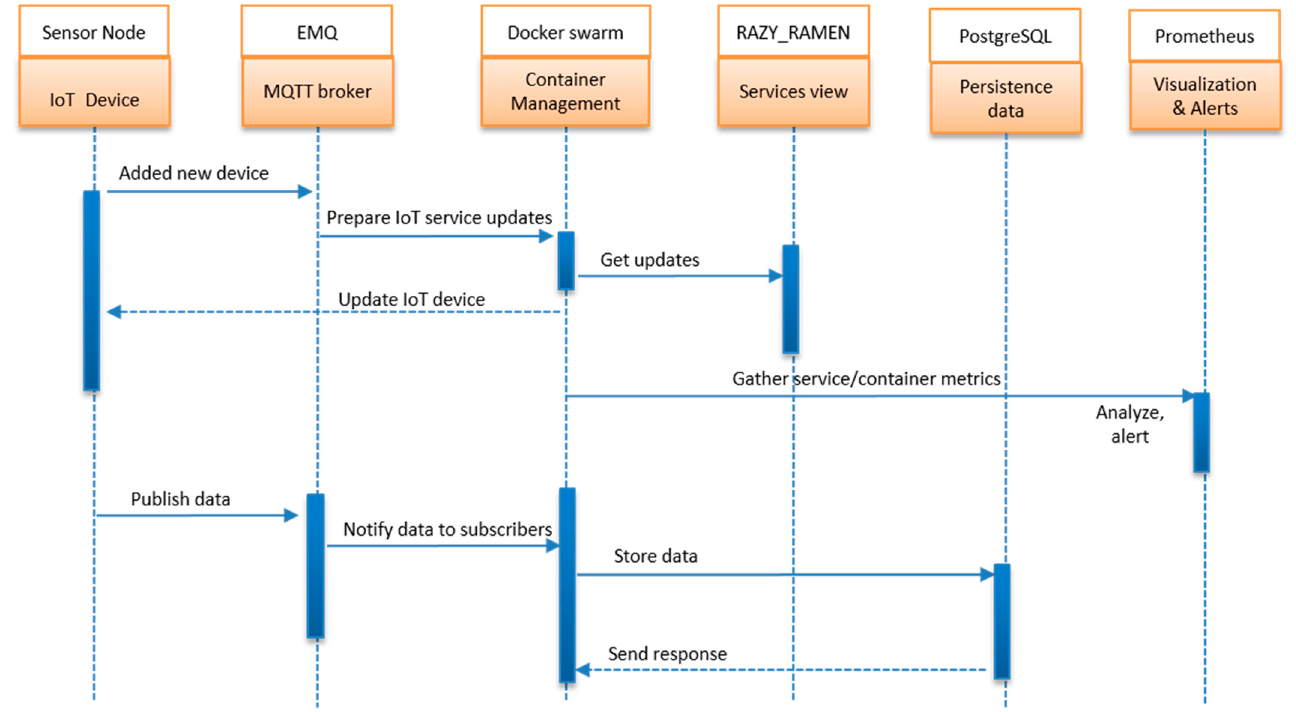
Figure 7. Sequence diagram activity at the sensor node perspective.